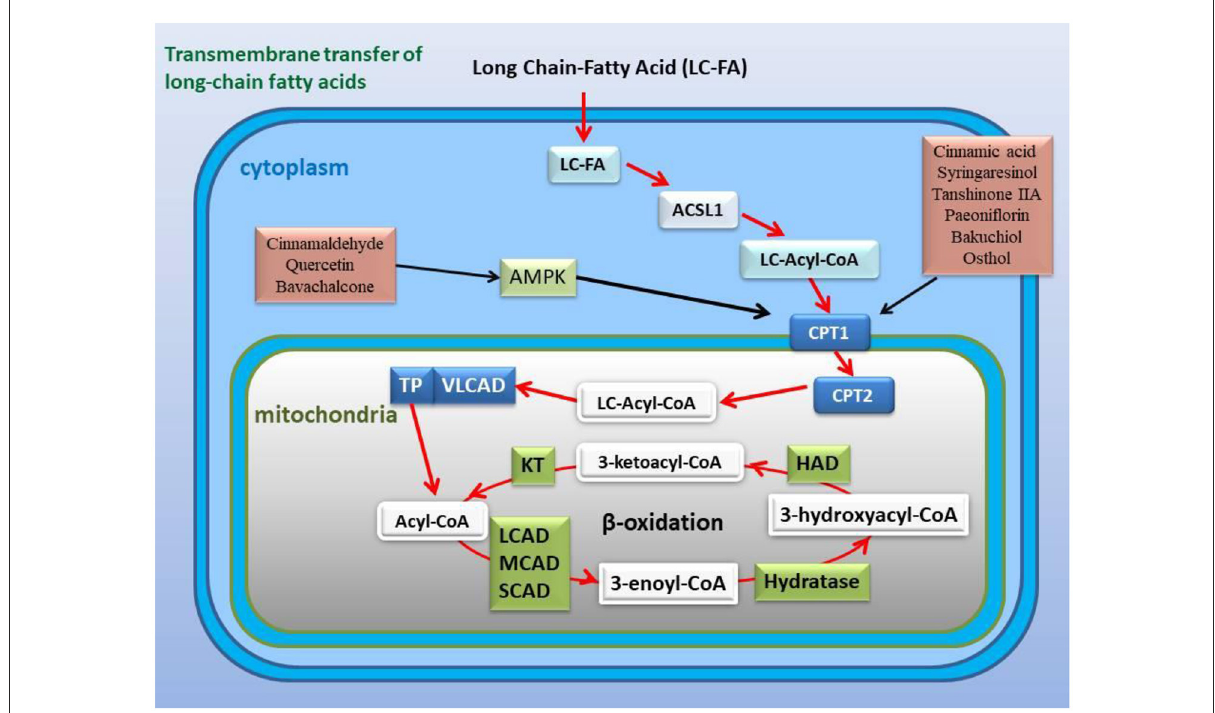
FIGURE6 Active ingredients in the classic formulas activate the expression or activity of CPT1 and improve fatty acid β -oxidation with or without the AMPK pathway. CPT1 is a key channel for long-chain fatty acids across the mitochondrial outer membrane, and its activity or expression affects the β -oxidation of fatty